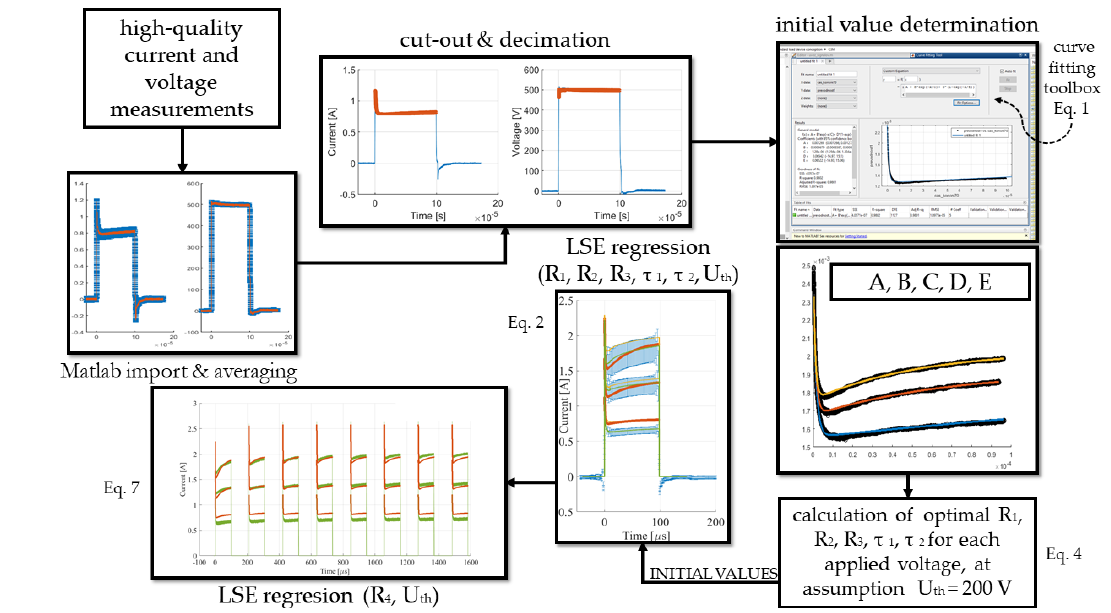
Figure 2. Flow chart of numerical calculations in